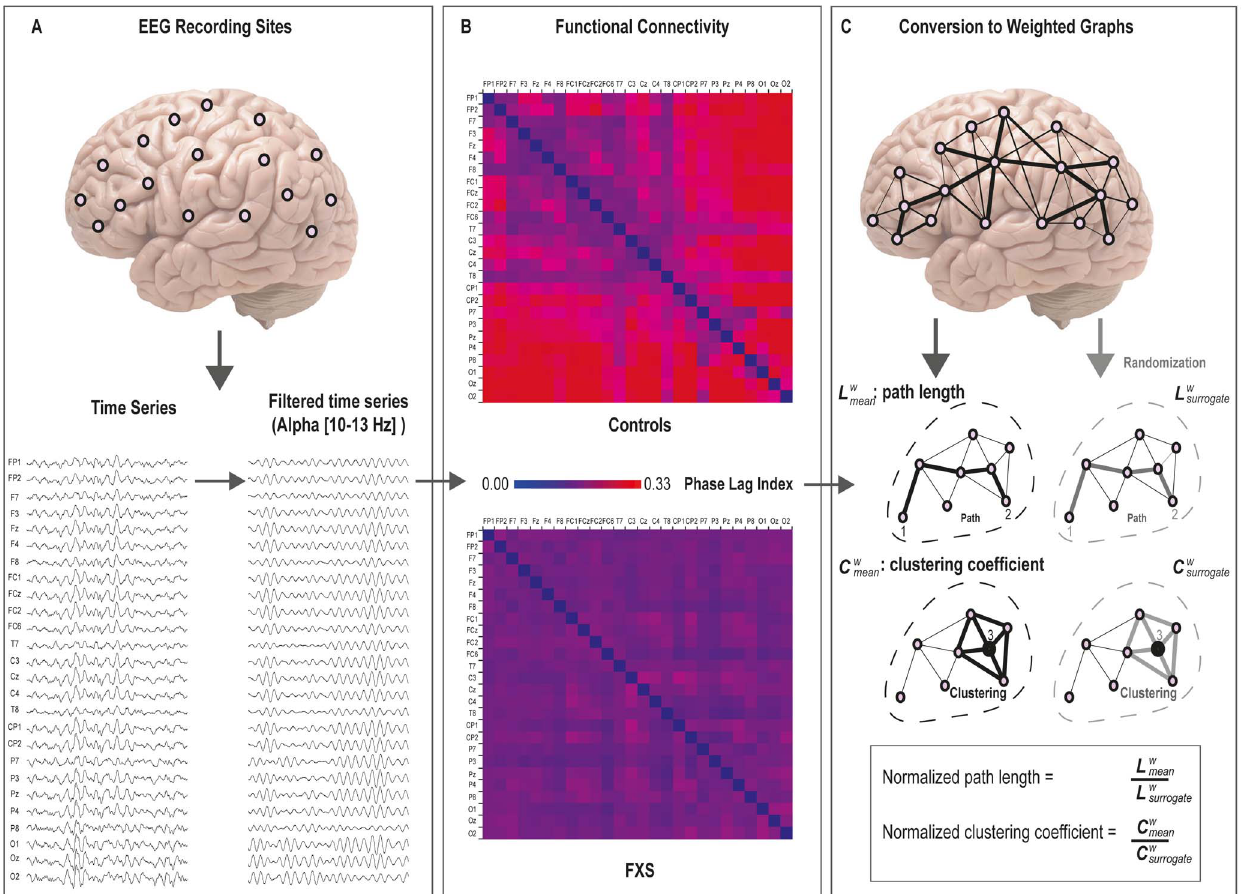
Figure 1. An overview of the method used to calculate weighted graphs. (A) EEG time-series from the 26 scalp electrodes were separately filtered for the delta, theta, alpha low, alpha high, beta, and gamma frequency bands. Higher alpha (10–13 Hz) is shown here as largest group differences were found for this frequency band. (B) Functional connectivity between all 26 6 26 electrode pairs was calculated based on the phase lag index, yielding connectivity values between 0 and 1 (higher values reflect more synchronization between electrodes). (C) When using graph theoretical analysis on EEG time series, electrodes represent ‘‘nodes’’ and the distance between these nodes represent the ‘‘edges’’ in the graph. PLI scores were used to calculate the path length (distance between the nodes) and the clustering coefficients (the degree in which nodes cluster together). In addition, a randomization procedure is employed to obtain measures independent of network size. From each original graph, random networks were derived by randomly shuffling the edge weights. Mean values of weighted graphs are then determined by dividing the original graph measures by these ‘surrogate’ measures.